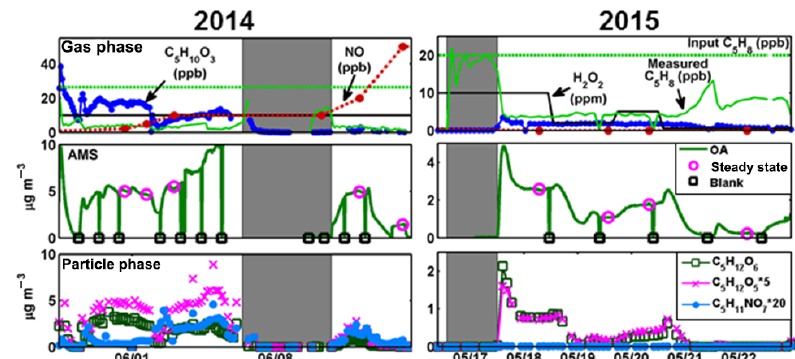
Figure 1. Overview of the 2014 and 2015 measurements taken at the PNNL. The left column is data from the 2014 campaign, and the right column is 2015. The top row shows gas-phase compounds measured by the PTR-MS and FIGAERO-CIMS as well as input concentrations of H 2 O 2 , NO, and isoprene. Middle row shows the OA as measured by the AMS. Steady-state periods are shown within magenta circles, AMS blanks as black squares. Select particle-phase species measured by the FIGAERO-CIMS are in the bottom row. Grey shaded areas in each column indicate when chamber lights were off for chamber cleaning and a dark NO 3 experiment (in 2014) that is not discussed here. Note that the axis limits are not the same due to a wide range in concentrations across years, while C 5 H 12 O 5 has been enhanced 5 × and C 5 H 11 NO 7 has been enhanced 20 × in the bottom rows to clearly show the behavior of each species on the same axis.